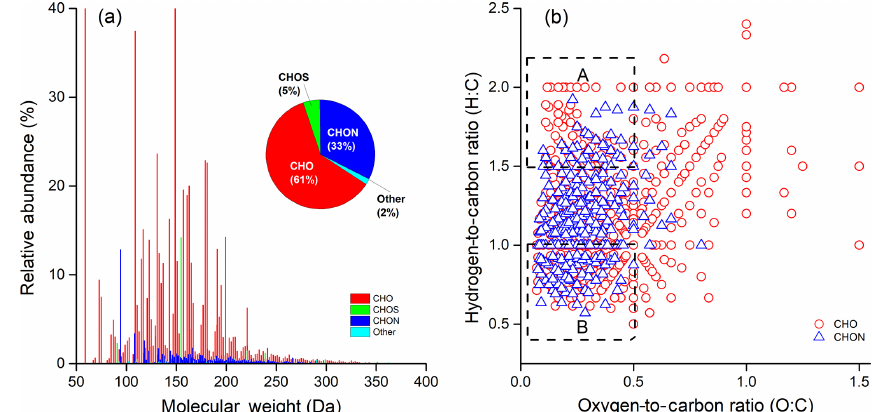
Figure 2. (a) Reconstructed mass spectra for detected ions with assigned formulas and (b) Van Krevelen diagrams for CHO and CHON species in extract of HNWX-1 sample. The inset pie charts in (a) show the number fraction of each class in the total assigned compounds. Areas A and B in (b) are tentatively attributed to aliphatic and aromatic species,